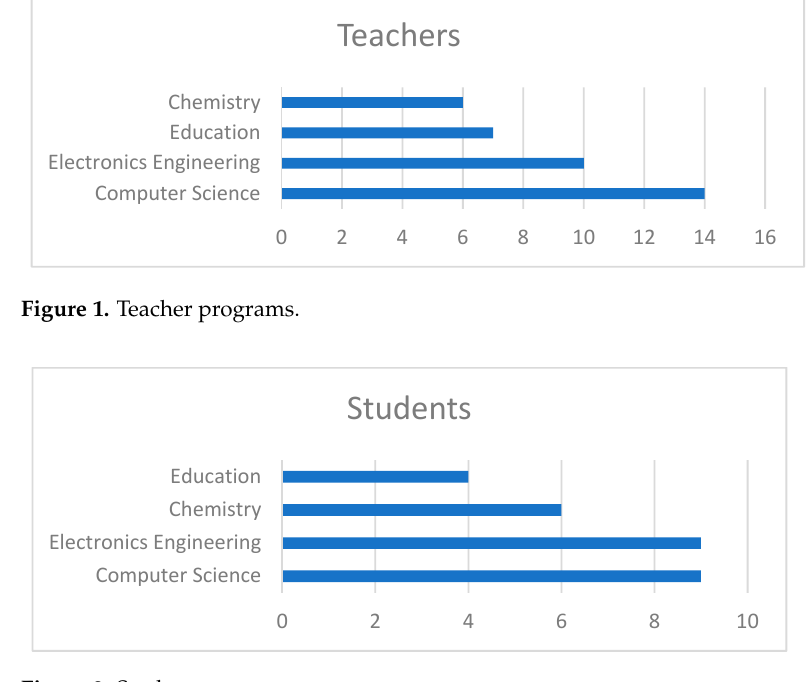
Figure 2. Student programs.